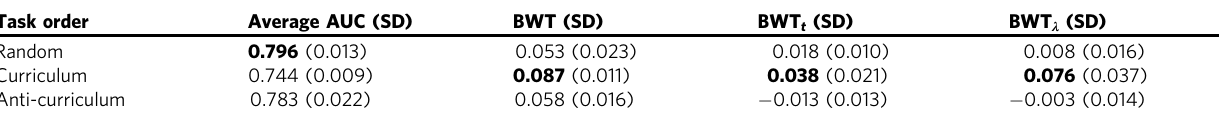
The storage and acquisition fractions are b = 0.25 and a = 0.50, respectively. The mean and standard deviation (SD) are shown across fi ve seeds. Bold results re fl ect the curricula leading to the best performance. The constructive interference exhibited by a deep-learning system following a curriculum based on our task-instance parameters supports our interpretation of such parameters as a proxy for instance dif fi